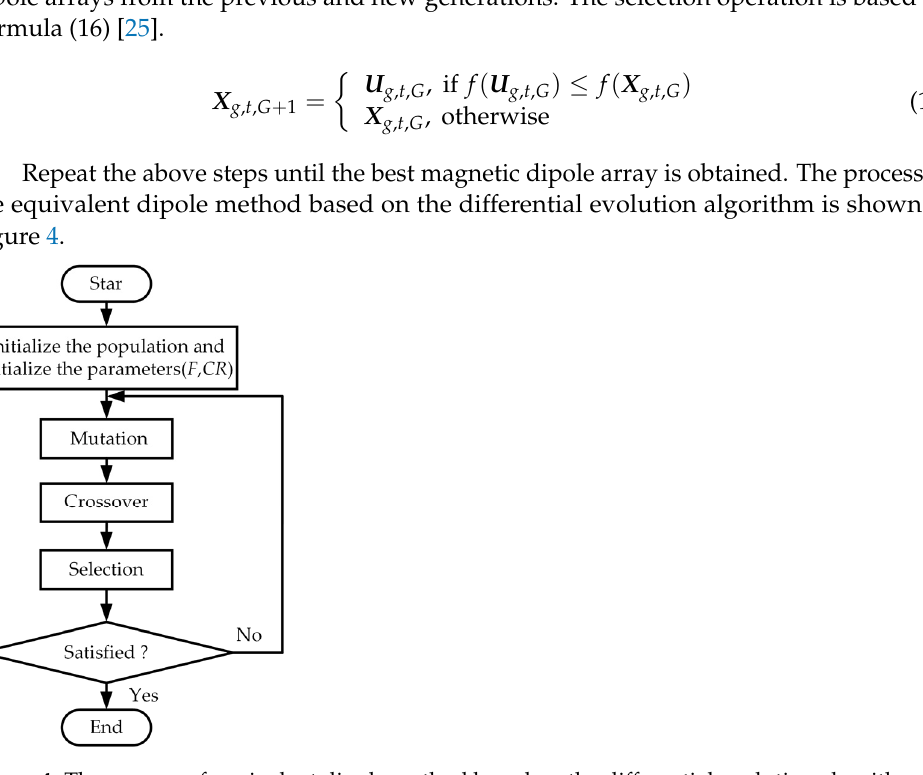
Figure 4. The process of equivalent dipole method based on the differential evolution algorithm.